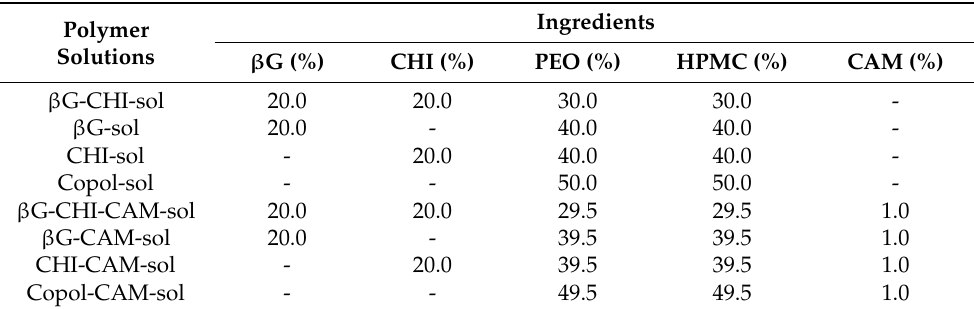
Table 1. Composition (% ( w / w )) of the dry material in the polymer